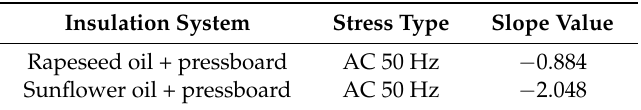
Table 2. Experiment results—slope comparison of measured characteristics.